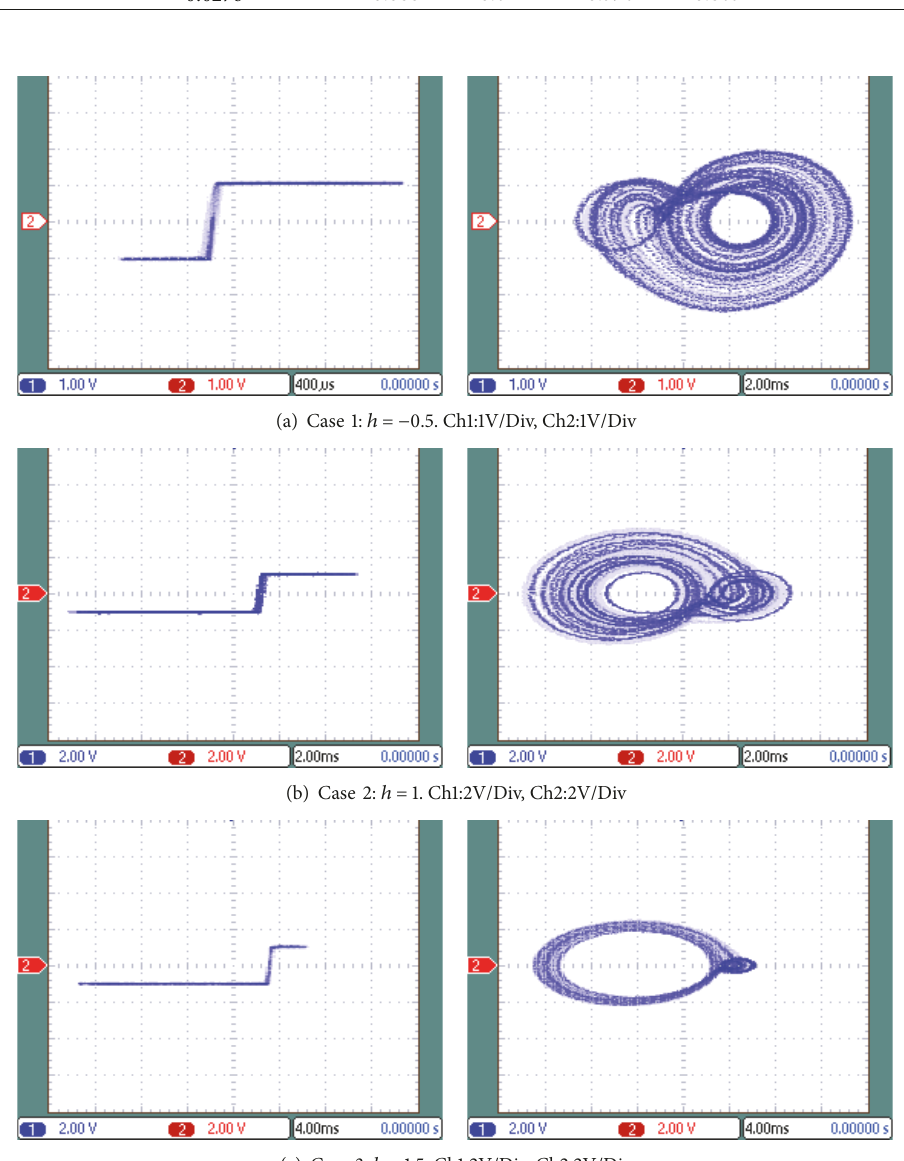
Figure 9: Experimental verification of optimized 2 scrolls using irregular SNLFs with different delays given in Table